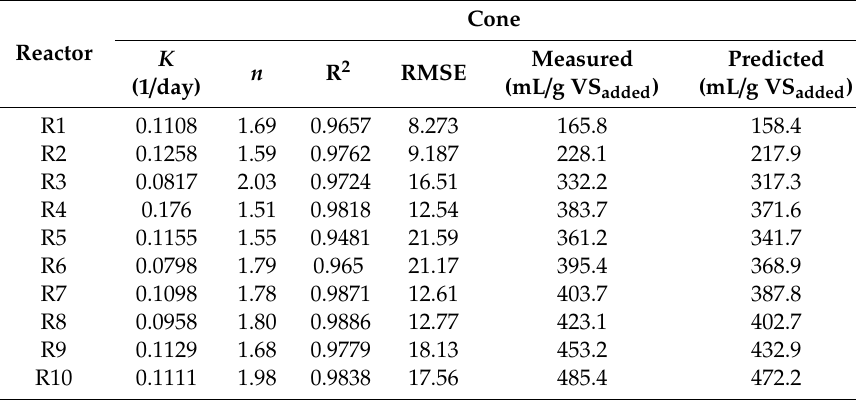
Table 7. Results from the cone